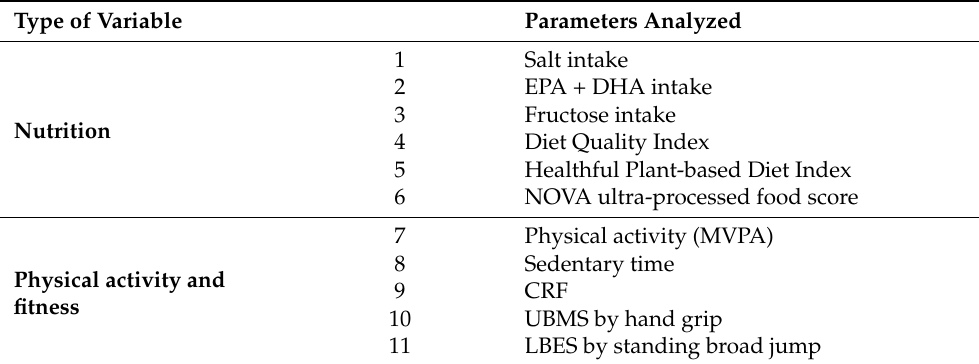
Table 7. List of the HELENA adolescent characteristics included in BELINDA primary outcome analysis, according to the study sample size